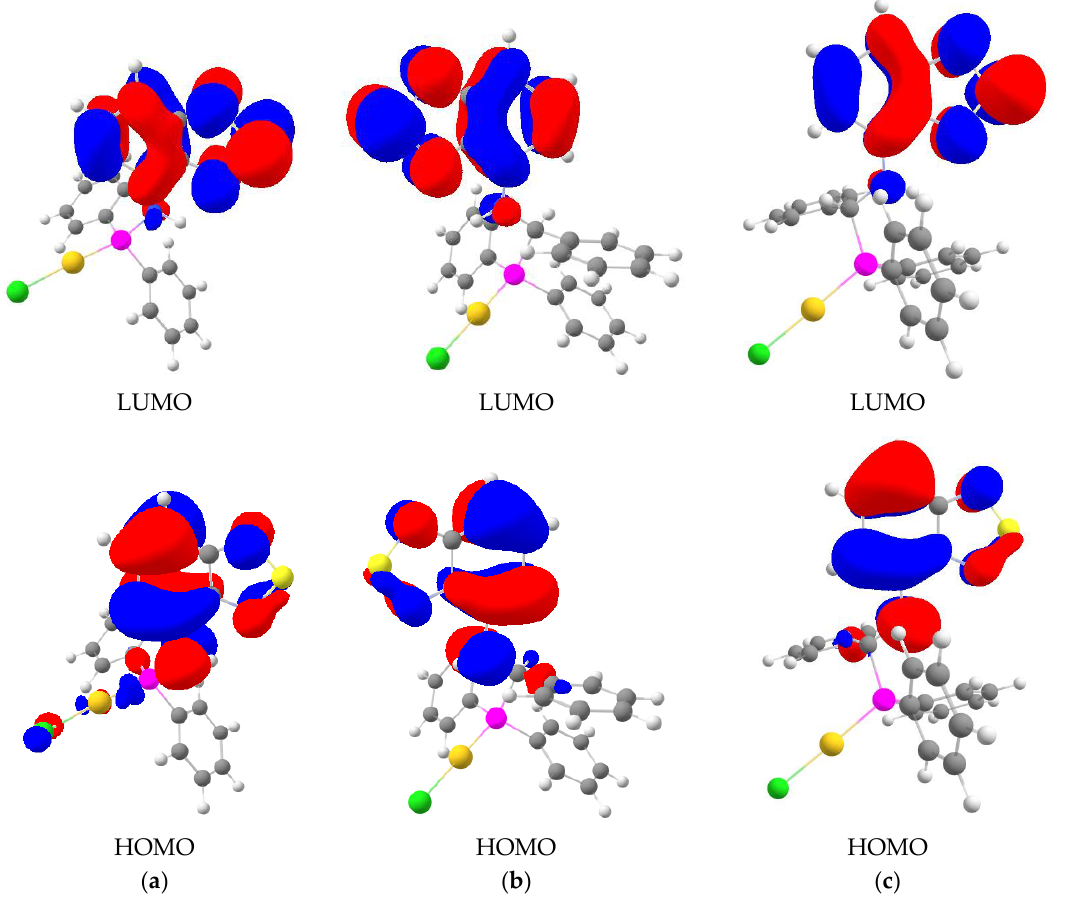
Figure 4. Frontier orbitals for compounds 1 ( a ), 2a ( b ), and 2b ( c ) at their S 0 equilibrium geometries (isovalue = 0.03).